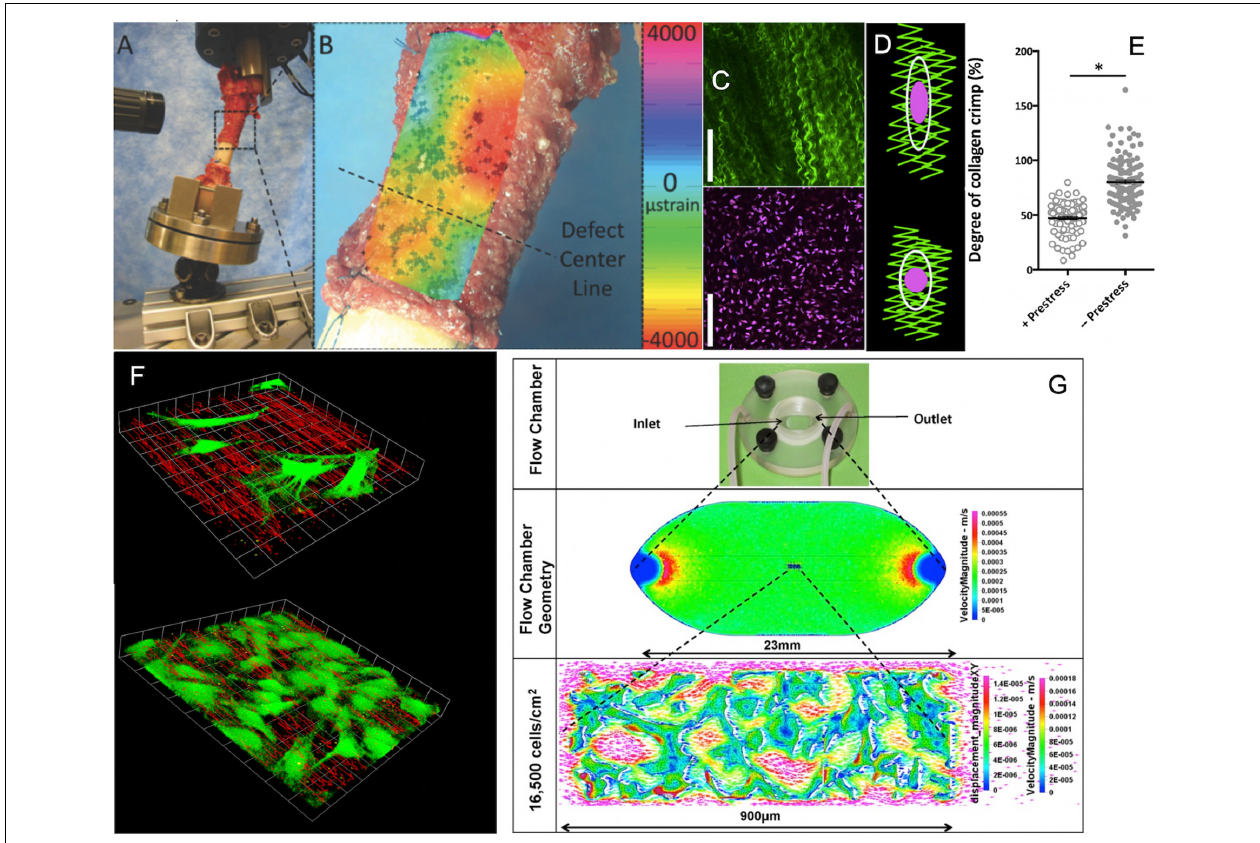
FIGURE 2 | Cross length and time scale experimental and coupled computational approaches to map the mechanome. (A) Ultra high resolution digital image correlation and (B) strain mapping of the periosteum milieu using high definition television lenses and ex vivo loading of the sheep femur to mimic stance shift loading after treatment of a critical sized defect with periosteum in situ. After (Knothe Tate et al., 2007; McBride et al., 2011a), used with permission . (C) High resolution imaging of collagen (green) and periosteum derived stem cell nuclei ex vivo to visualize hypothesized mechanism of modulating stem cell quiescence via loss of intrinsic prestress with injury. After (Yu et al., 2017), used with permission . (D,E) In its natural, healthy state, periosteum is attached under prestress to every bone surface like Velcro, through a multitude of collagenous Sharpey’s fibers. When the Sharpey’s fibers become detached, e.g., due to trauma, the pre-tensioned, crimped collagen relaxes and becomes more crimped (less stretched), after (Yu et al., 2017), used with permission . (F) Using computational fluid dynamics predictions and computer-aided design and manufacture, perfusion chambers were manufactured to deliver precise volumetric flow fields to cells and tissue templates cultured within. The system was designed to enable concomitant microscopy, demonstrating the effect of cells themselves on local flow fields, when seeded at low density (top) and at near confluence (bottom), after (Song et al., 2010, 2012, 2013), used with permission . (G) After full computational and experimental validation of the system, including mechanical stresses delivered and resulting deformation on cell/tissue surfaces, tissue templates were tested using the same experimental platform and paired with multiphysics computational methods to enable near-real time mechanical testing of cells and tissue templates as they evolve (change phenotype and/or change their baseline gene expression of transcription markers typifying lineage commitment pathways), after (Song et al., 2010, 2012, 2013), used with permission . ∗ Indicates a significant differences, as defined by a p <